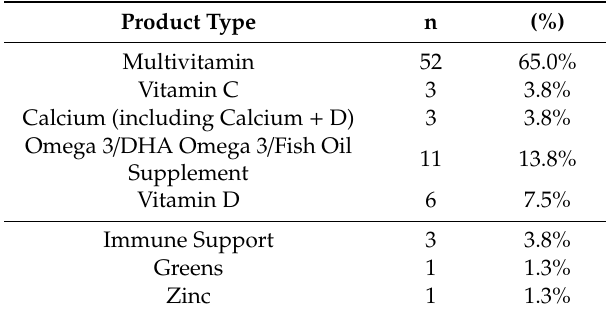
Table 3. Breakdown of Vitamin / mineral / supplement (n =